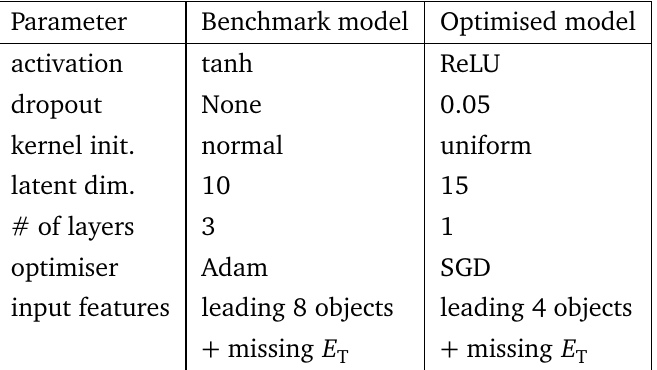
Table 6: Hyperparameters and input features for the benchmark model, as well as the model optimised specifically for Channel 2a after a grid